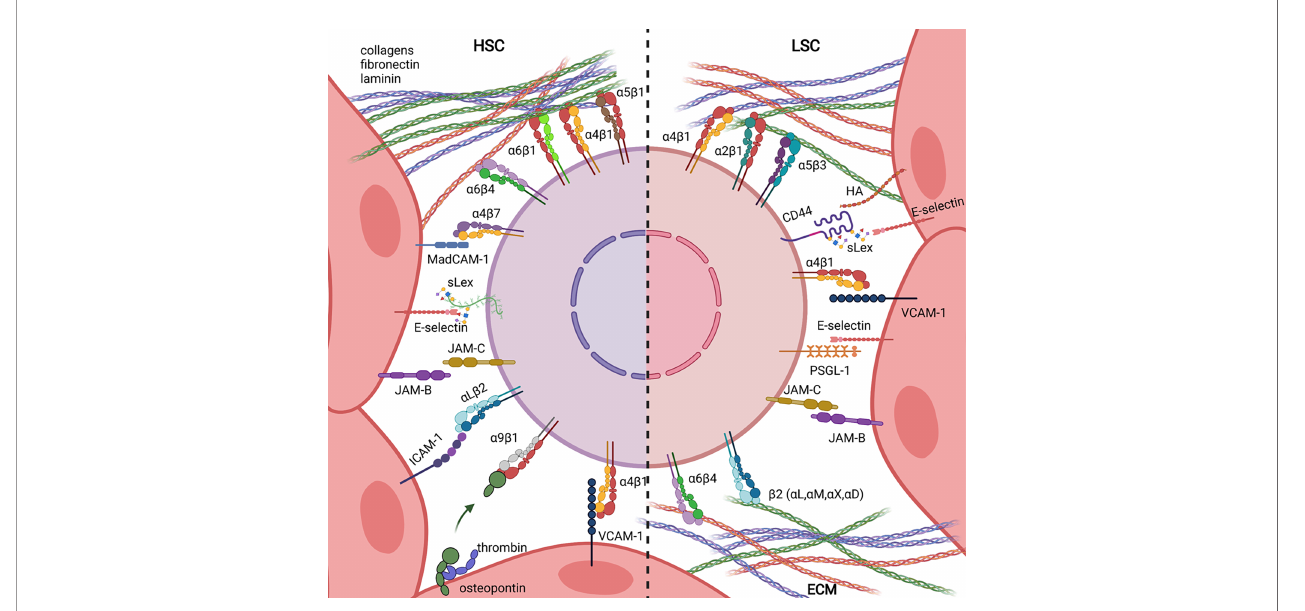
FIGURE 1 | Ligand/Receptor adhesion pairs involved in Haematopoietic Stem Cell (HSC, left) and Leukemic Stem Cell (LSC, right) retention in bone marrow